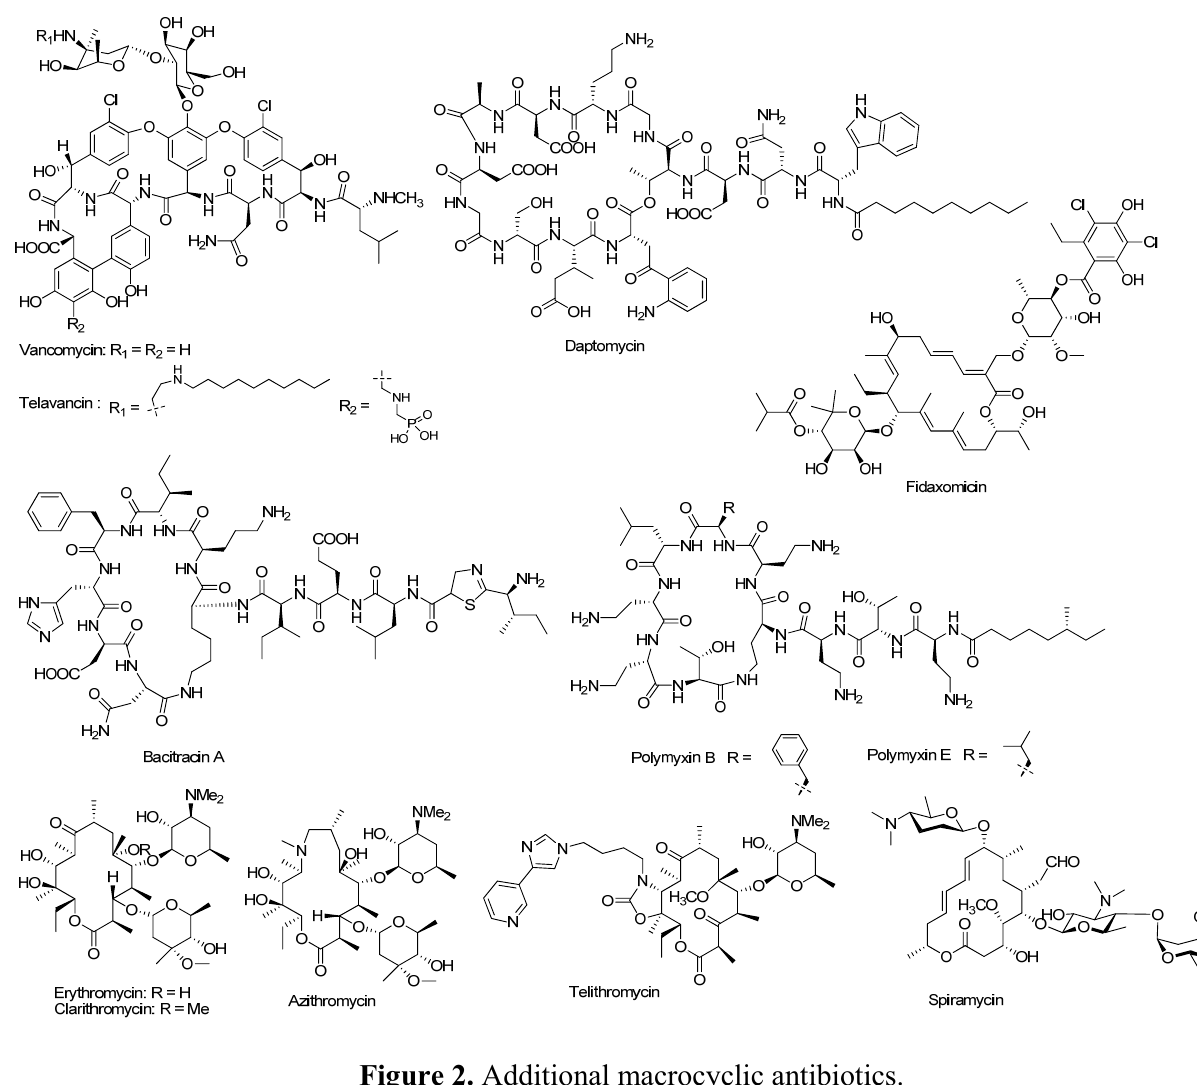
Figure 1. Clinically used macrocyclic antibiotics.